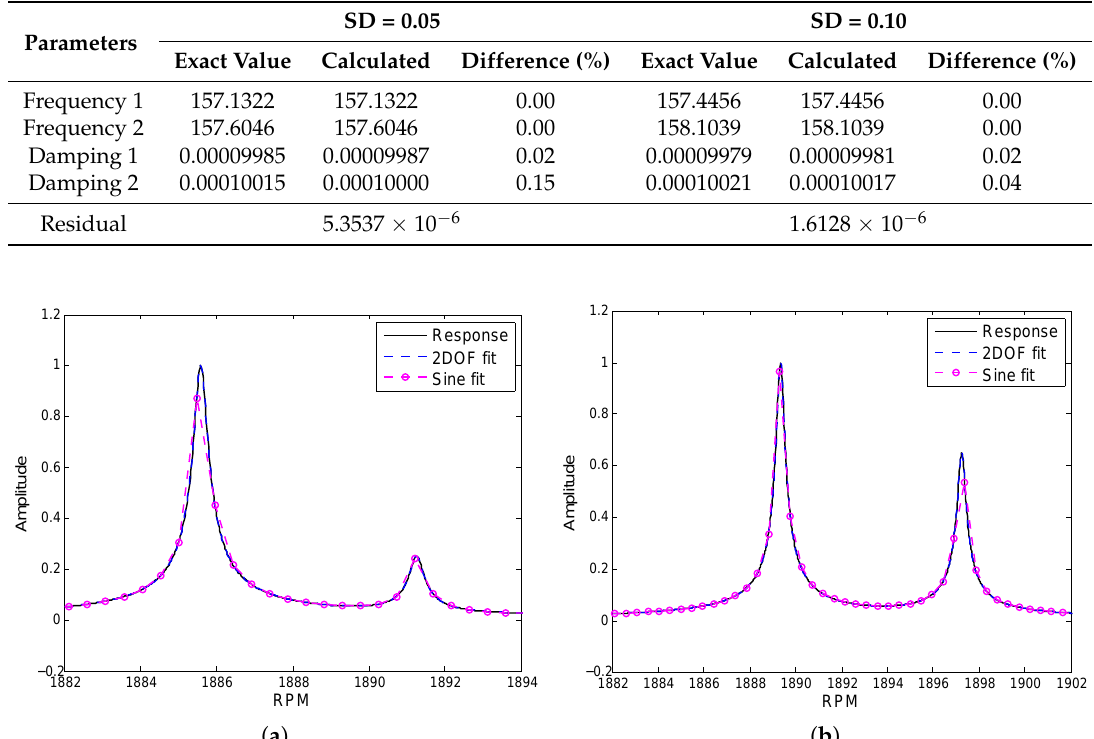
Figure 7. Comparison of non-dimensional amplitudes obtained by different fitting methods for EO = 5 and ζ 1,2 = 0.0001, ( a ) SD = 0.05, ( b ) SD = 0.10.